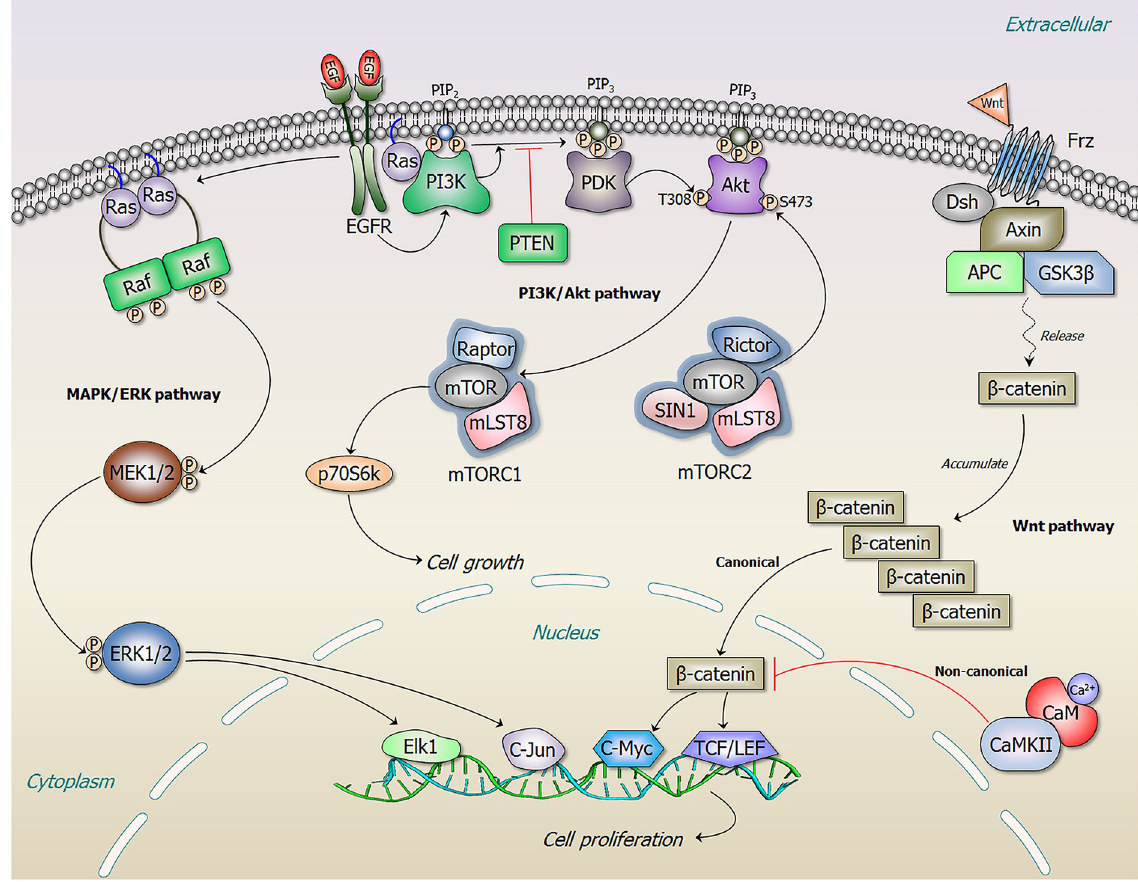
Fig 10. A general scheme of cell-signaling pathway. Representatives shown for the MAPK, PI3K/Akt, and Wnt pathways. In the MAPK pathway, Ras gets activated in the presence of the EGFR signal and forms nanoclusters that promote Raf dimerization. Autophosphorylated, active Raf dimer phosphorylates and activatesMEK 1/2, and subsequently phosphorylates and activates ERK 1/2, leading to cell proliferation. In the PI3K/Akt pathway, both Ras and RTK activate PI3K, recruiting it to the plasma membrane, where PI3K phosphorylates PIP 2 to produce PIP 3 . The tumor suppressor PTEN can reverse the PIP 3 production. PIP 3 recruits both PDK and Akt to the plasma membrane, where PDK and mTORC2 activate Akt, and active Akt phosphorylates the mTORC1, leading to cell growth. The canonical Wnt pathway involves an accumulation of β -catenin in the cytoplasm and translocates β -catenin to the nucleus where it binds to TCF/LEF transcription factors. β -catenin upregulates c-Myc. In the noncanonical Wnt pathway, CaM-bound CaMKII interfere with the canonical β -catenin/TCF/LEF signaling. CaM, Ca 2+ -calmodulin; EGFR, epidermal growth factor receptor; ERK, extracellular signal-regulated kinase; MAPK, Raf/MEK/ERK; MEK, MAPK kinase; mTORC1, mTOR complex 1; mTORC2, mTOR complex 2; PDK, phosphoinositide-dependent protein kinase; PIP 2 , phosphatidylinositol 4,5-bisphosphate; PIP3, phosphatidylinositol 3,4,5-bisphosphate; PTEN, phosphatase and tensin homolog; RTK, receptor tyrosine kinase; TCF/LEF, T-cell factor/lymphoid enhancing